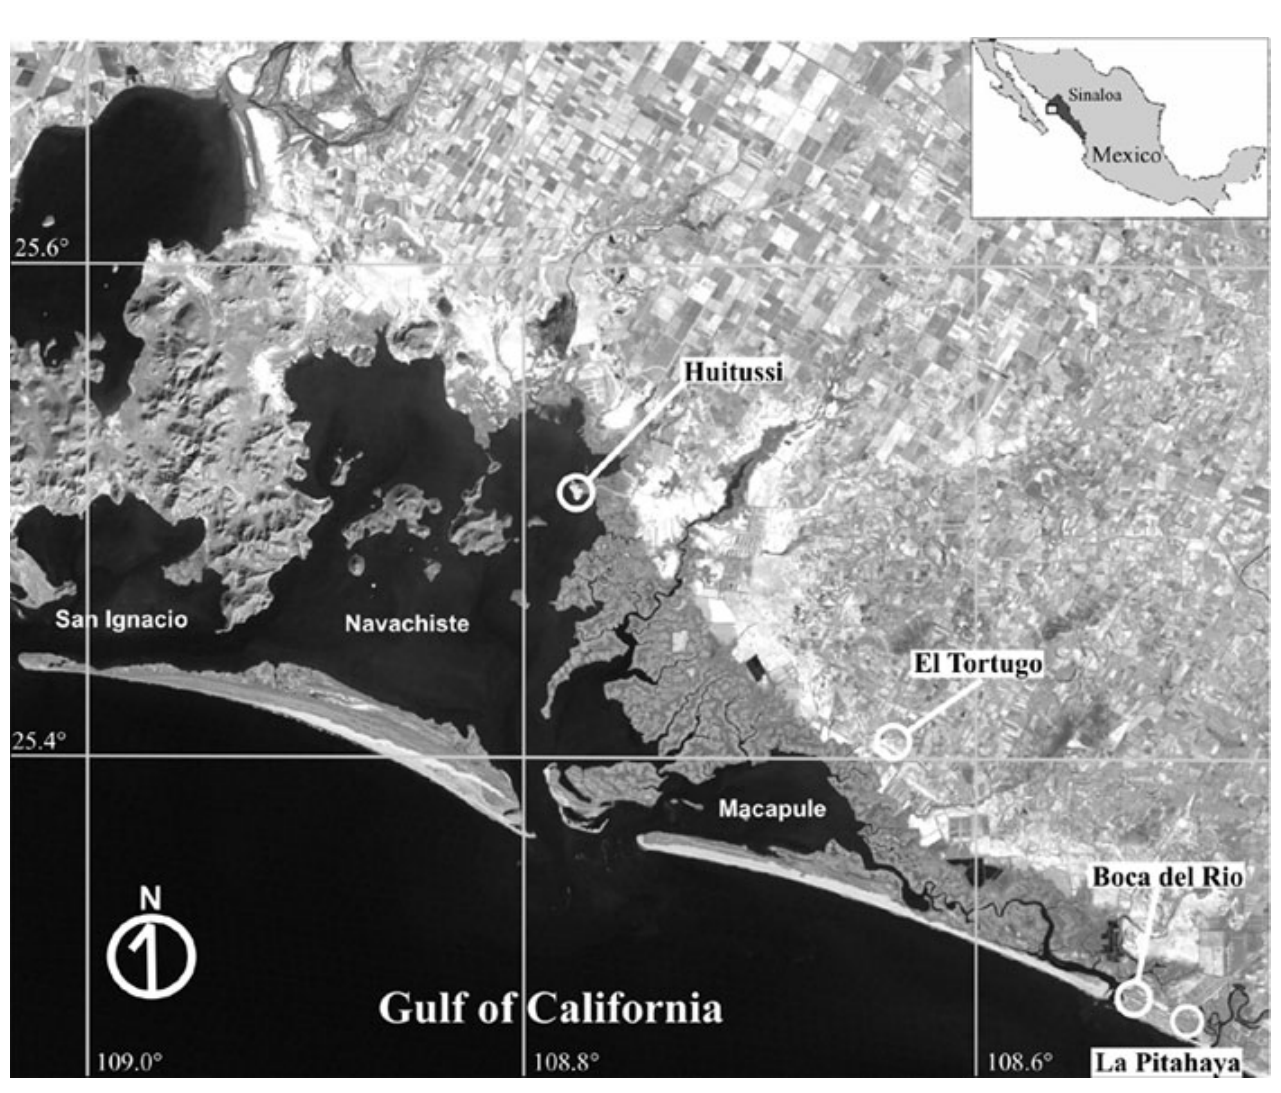
Fig. 1. Study area and location of the four fishery